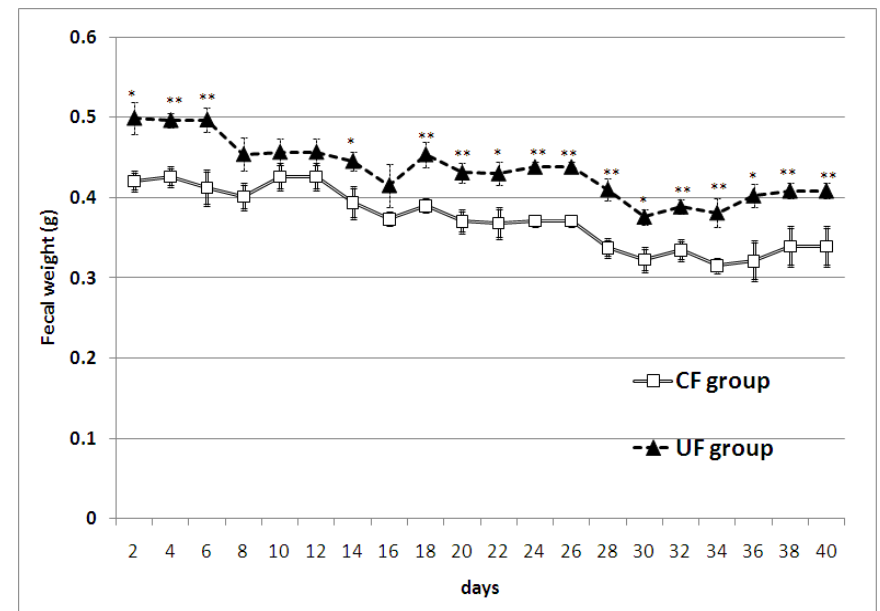
Figure 1. The amount of freeze-dried feces were significantly greater in the ume fiber (UF) group than in the cellulose (CF) group. Values are means ± SE (n = 7). The data were analyzed using t -test analysis. **Significantly different from the CF group (p < 0.01); *Significantly different from the CF group (p < 0.05).